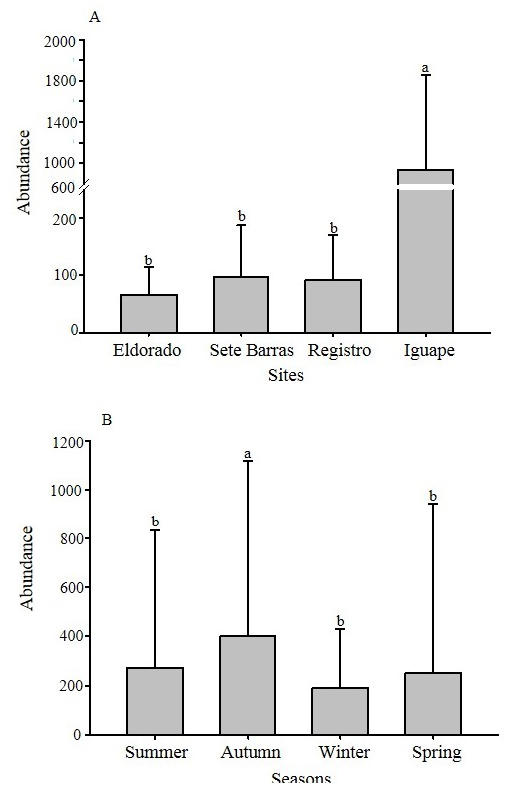
Figure 4. Mean abundance of Macrobrachium olfersii in the four sites ( A ) along the Ribeira de Iguape river, São Paulo, Brazil, and per season ( B ). GLM with a posteriori LSD test; different letters indicate significant differences at